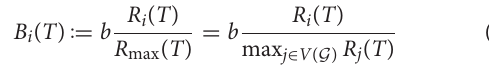
Frontiers in Robotics and AI |